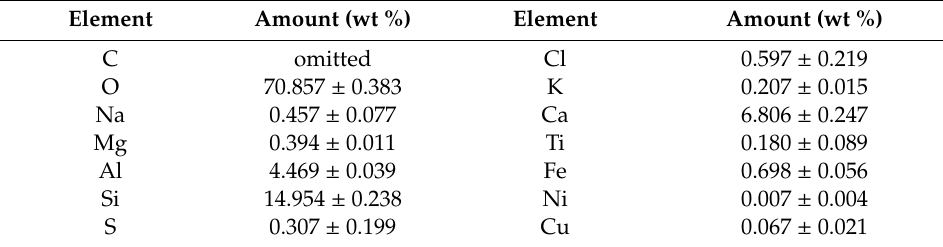
Table 3. Results of EDX analysis on WTB sample (carbon